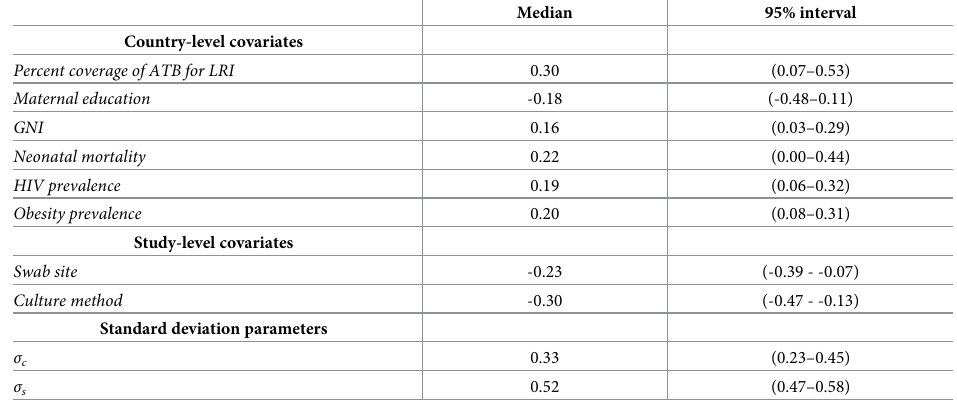
Table 1. Maternal GBS colonization hierarchical model. Coefficients at the study and country levels and standard deviation parameters. ATB = antibiotics; LRI = lower respiratory tract infections; GNI = gross national income per